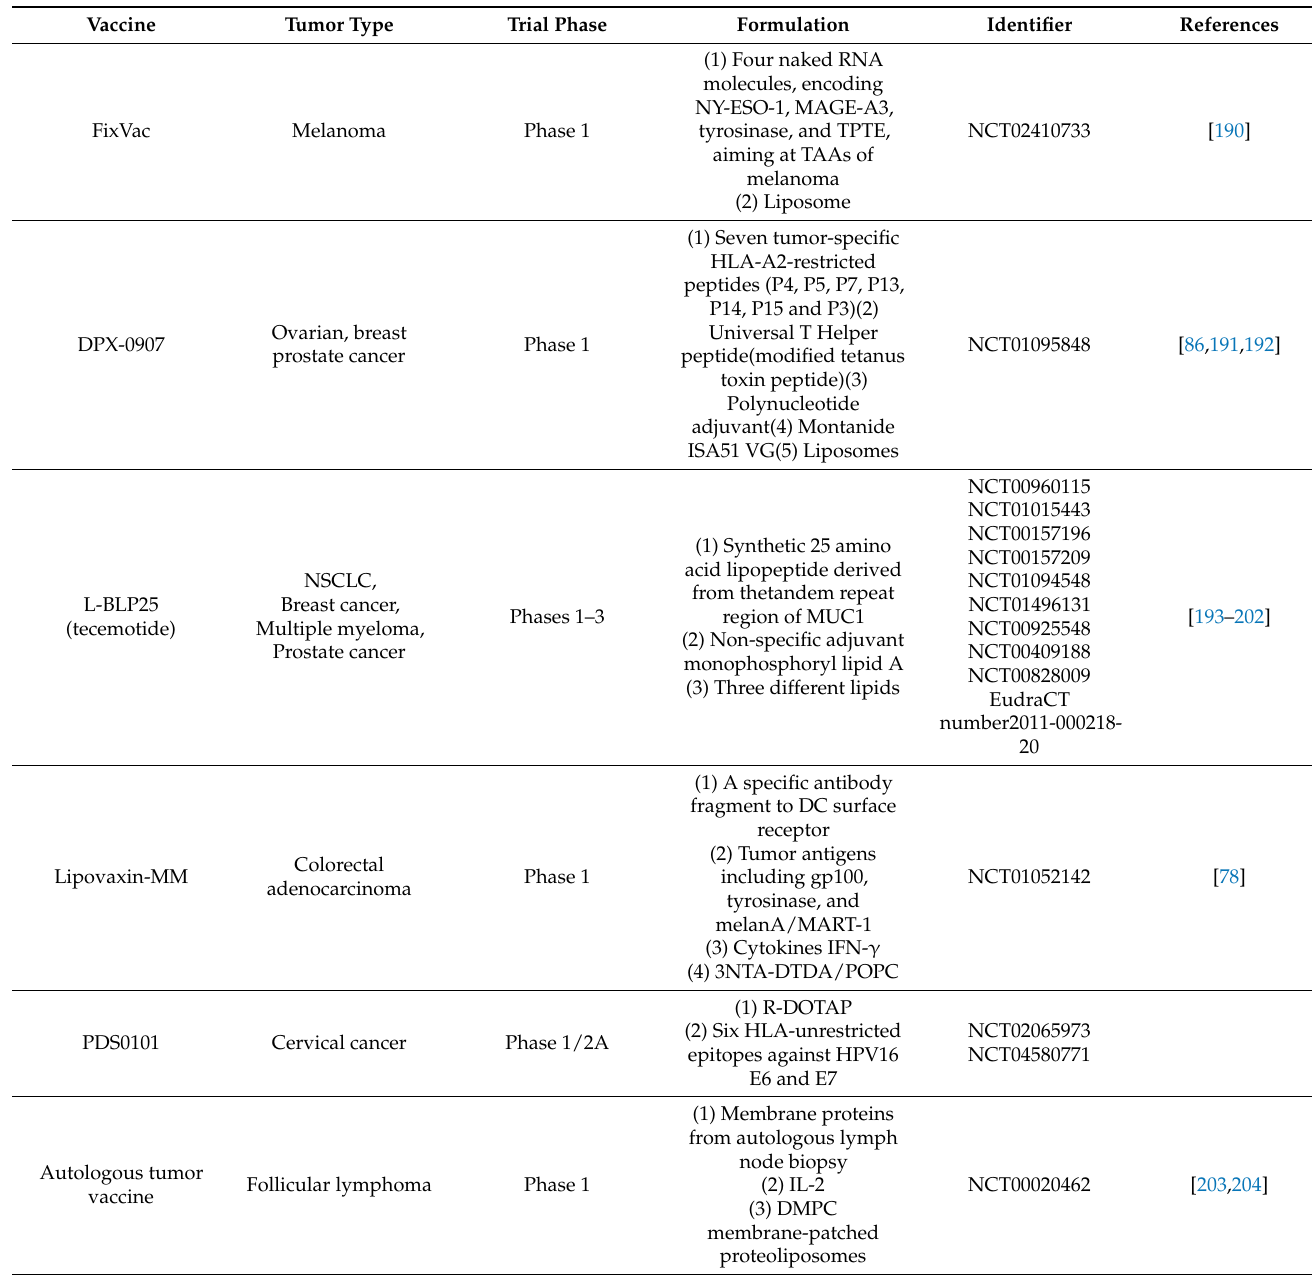
Table 4. Application of liposomal cancer vaccines in